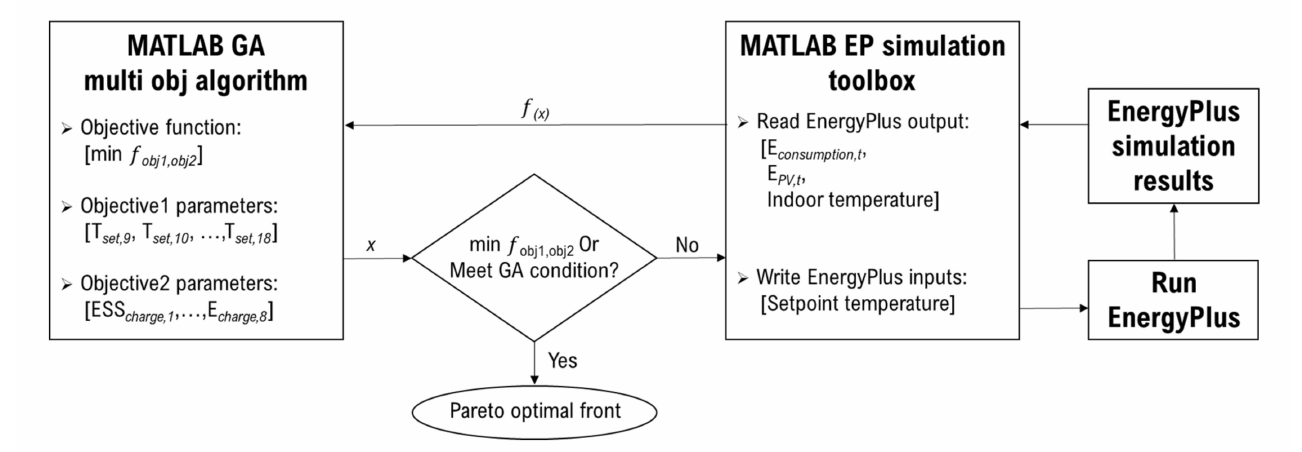
Figure 2. Proposed MPC scheduling algorithm optimized by GA.